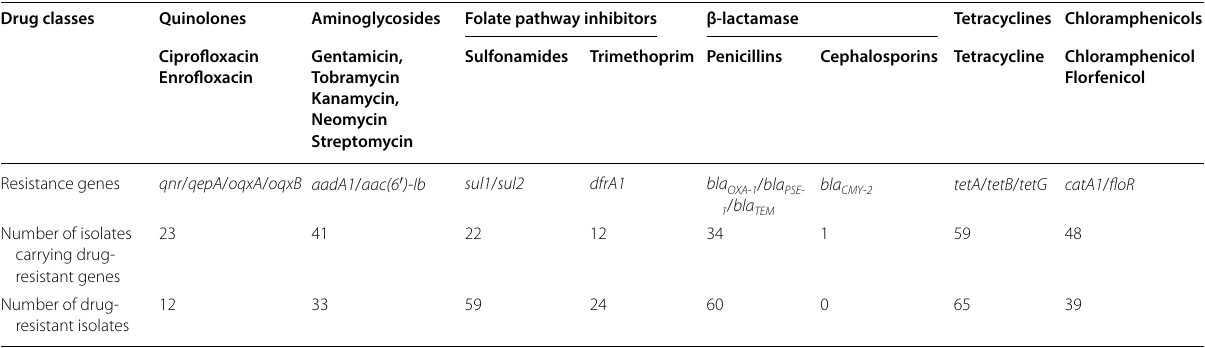
Table 7 Resistance genes and phenotype relationship of Salmonella isolates Drug classes Quinolones Aminoglycosides Folate pathway inhibitors